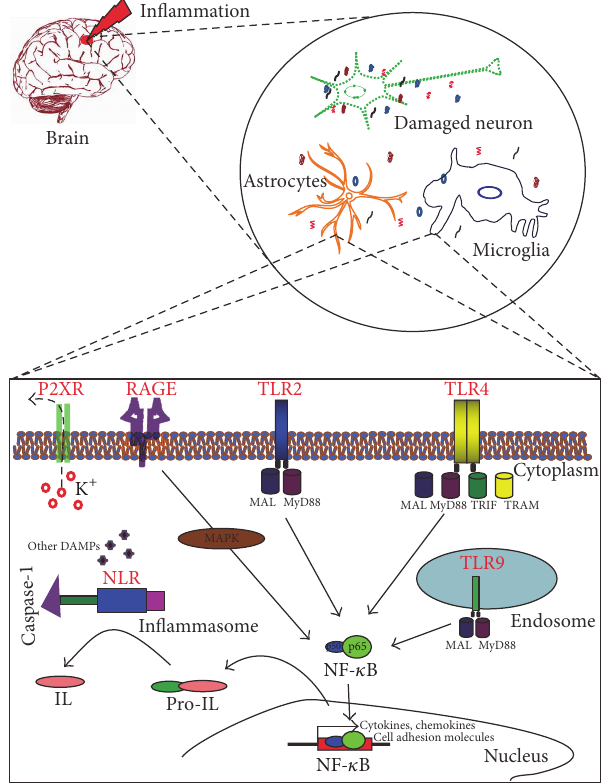
Damage-associated molecular patterns Figure 4: Mechanisms of glial cell activation in response to damage signals. Sterile neuroinflammatory conditions are characterized by the accumulation of misfolded and aggregated proteins in the brain. These DAMPs are released from different subcellular components of the damaged neurons, which trigger respective PRRs leading to downstream activation of proinflammatory cascades and enhancing effects of initial inflammatory insult. Activation of PRRs, primarily TLR2, TLR4, TLR9, and RAGE, converge largely into NF- 𝜅 B acti- vation, promoting cell death and/or contributing to neuroinflam- matory/neurodegenerative mechanisms. These pathways, including P2XR, jointly work with multiprotein inflammasome complex (NLRs) that assists the generation of mature cytokines from pro- forms via the activation of caspase-1. TLR, toll-like receptor; RAGE, receptor for advanced glycation end products; NLR, nod-like recep- tor; P2XR, ATP-gated purinergic P2 receptors; MyD88, myeloid differentiation primary response gene (88); MAL, MyD88-adapter- like; TRIF, TIR-domain-containing adapter-inducing interferon- 𝛽 ; TRAM, TRIF-related adaptor molecule; MAPK, mitogen-activated protein kinase; NF- 𝜅 B, nuclear factor-kappa B; IL,